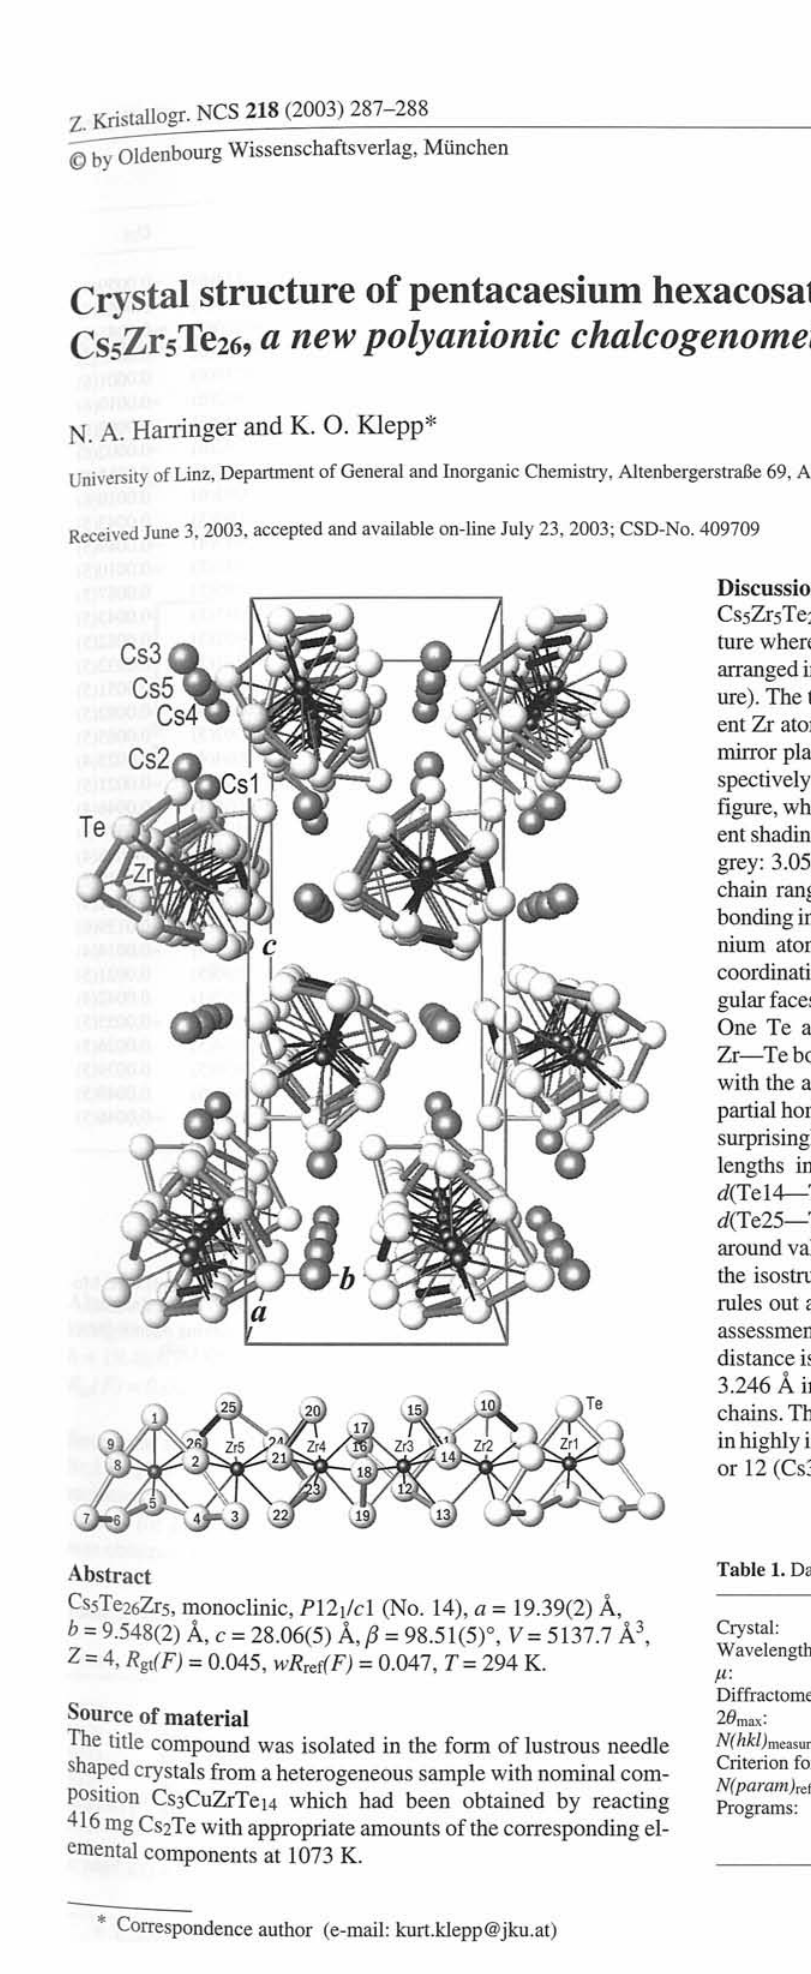
Table 1. Data collection and handling.